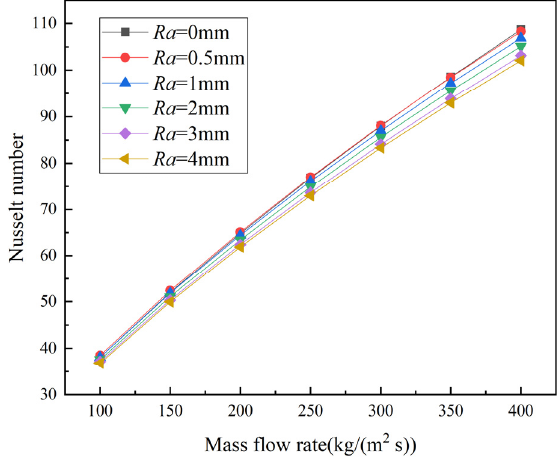
Figure 13. Nusselt number values of PCHEs at different mass flow rates for different curvature radii of inserted arc segments.